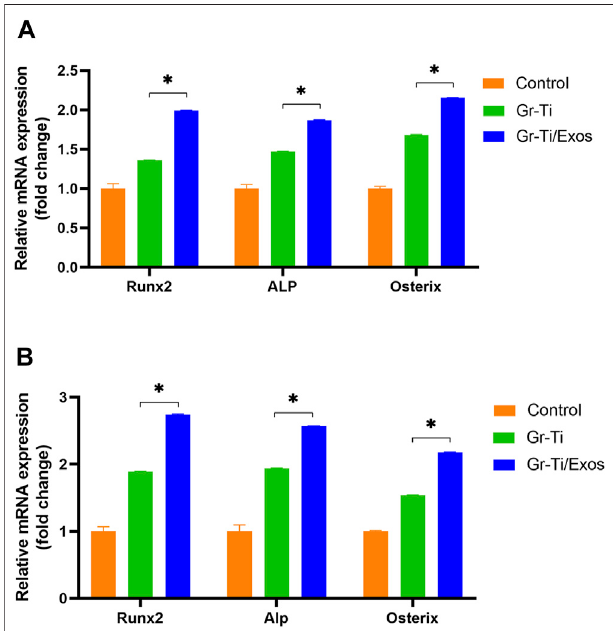
FIGURE 5 | Expression of osteogenic genes: (A) Osteogenic induction for 7 days; (B) Osteogenic induction for 14 days: the mRNA levels of RUNX2, ALP, and Osterix in the Gr-Ti/Exos group were signi fi cantly higher than those in the Gr-Ti group at both time points ( p p < 0.05).